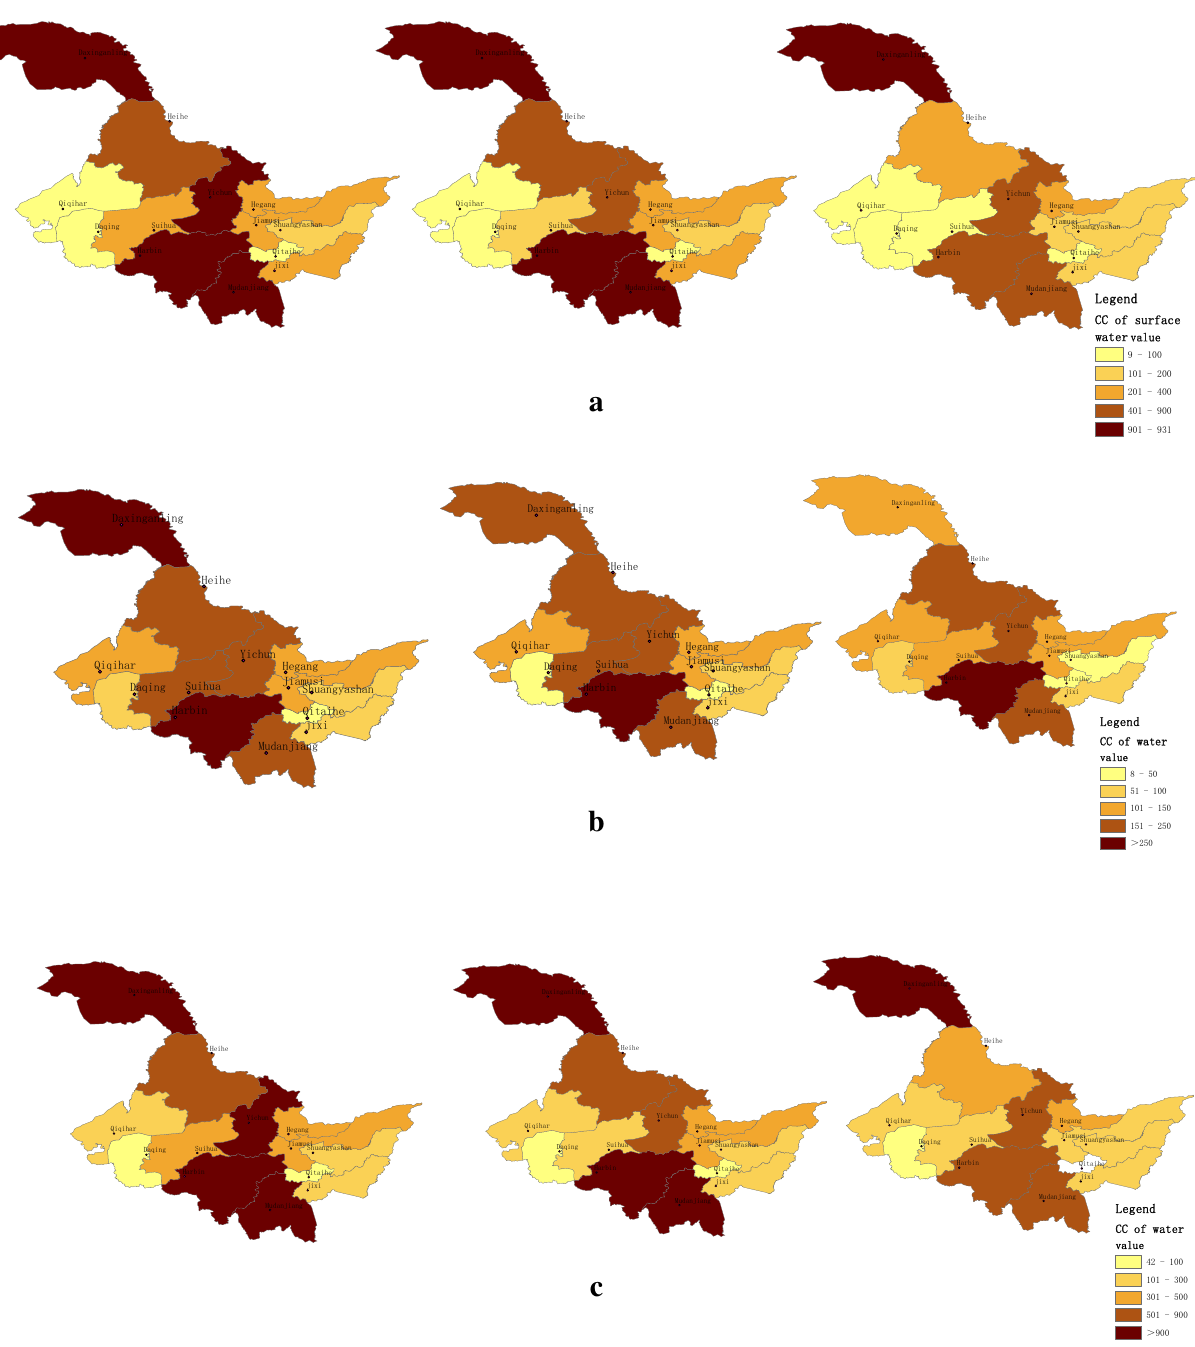
Fig. 3 Special distribution of water ECC about every city in Heilongjiang Province from 2009 to 2011. a The ECC of the surface water, b the ECC of the groundwater, c the ECC of the overall